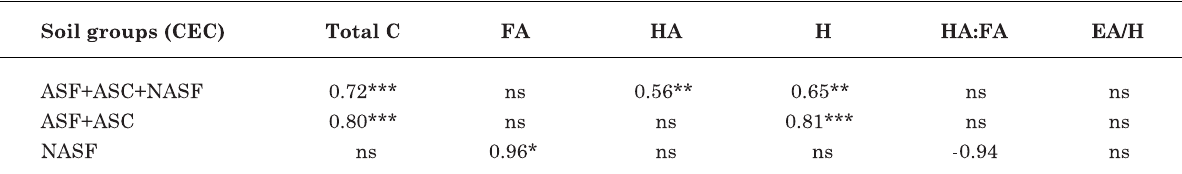
Table 4. Correlation between cation exchange capacity (CEC pH 7,0) and the humic substances (HS) fractions (FA, HA,